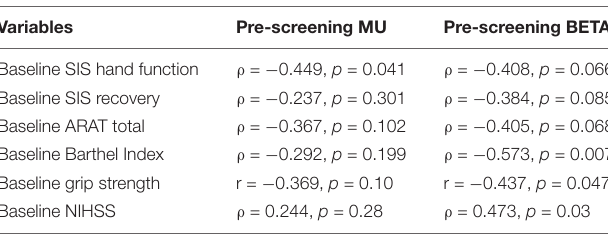
Variables Pre-screening